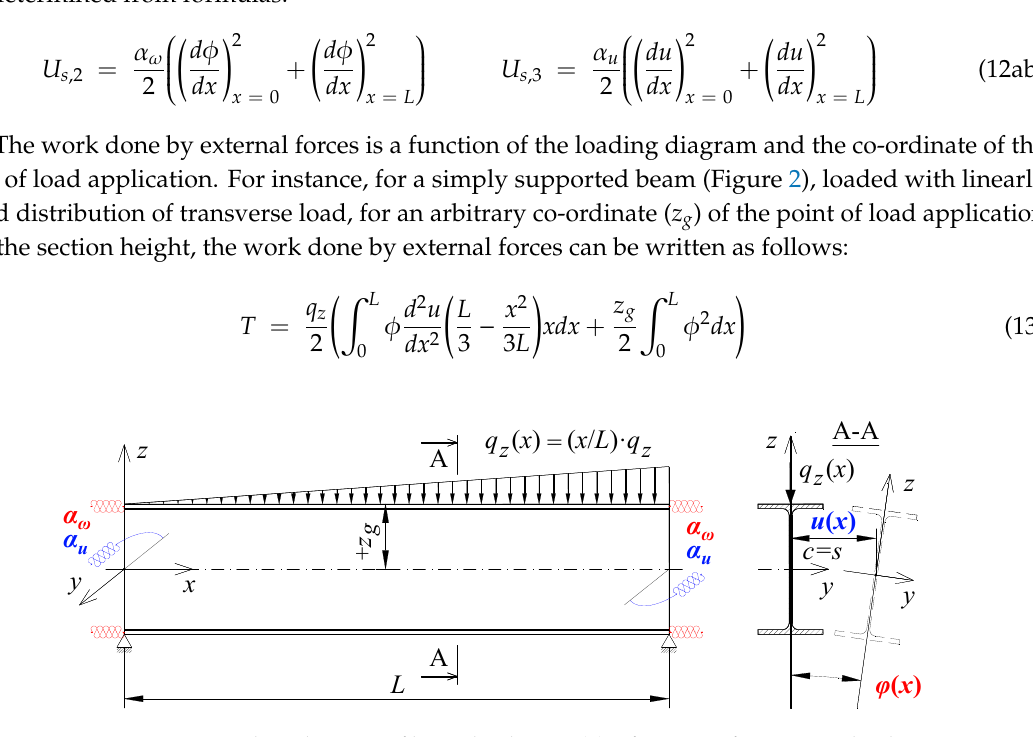
Figure 2. Exemplary diagram of beam loading. q z ( x )—function of transverse load.